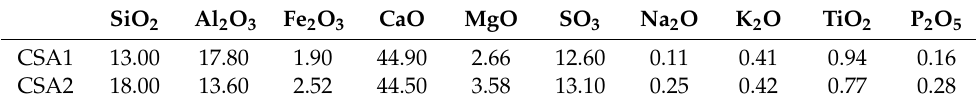
Table 1. Chemical composition of cements Wt/%.